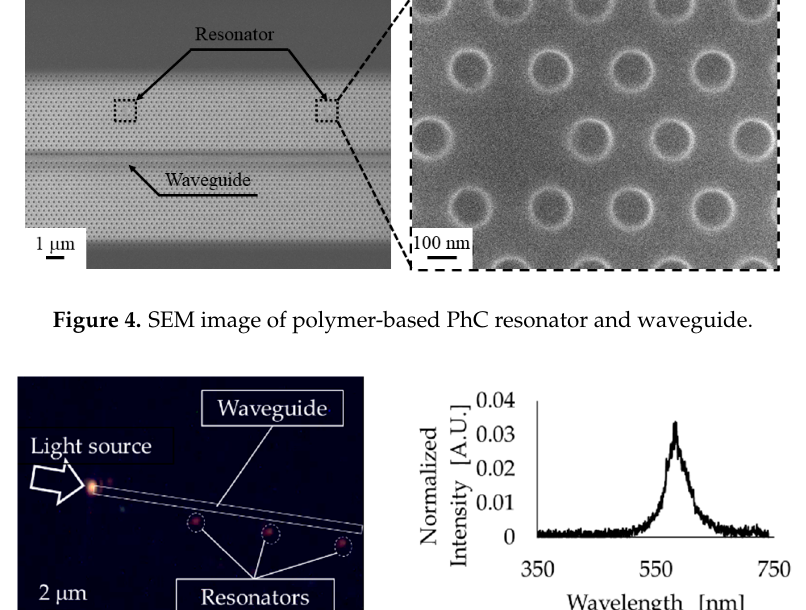
( b ) Figure 6. ( a ) Fabrication of the three-defect PhC resonator and waveguide. ( b ) Comparison of intensity with one and three defects.